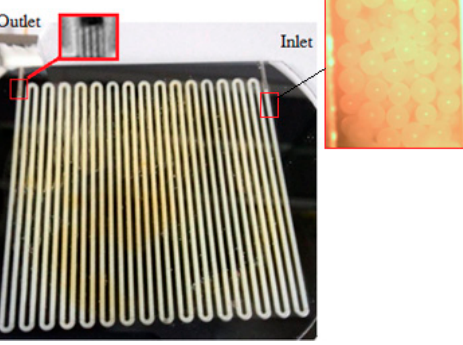
Figure 2. The fabricated micro GC column packed with porapak Q stationary phase.